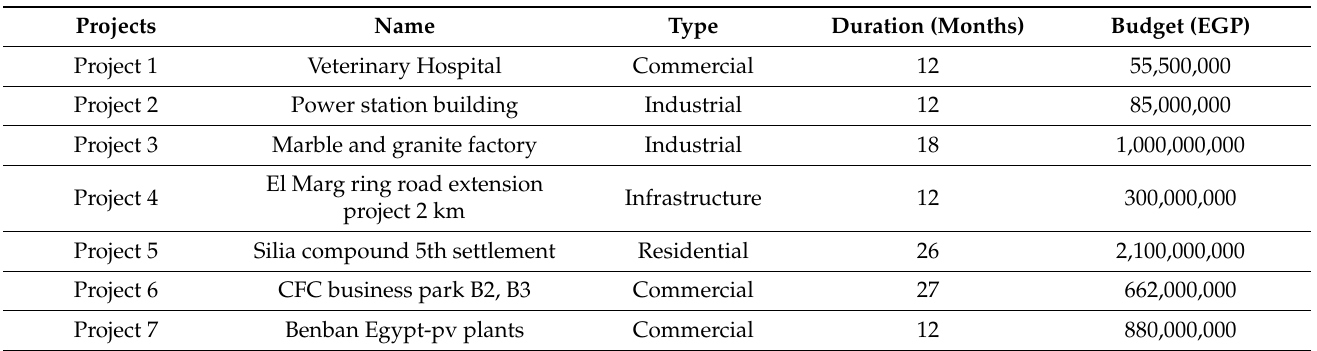
Table 6. The details of the